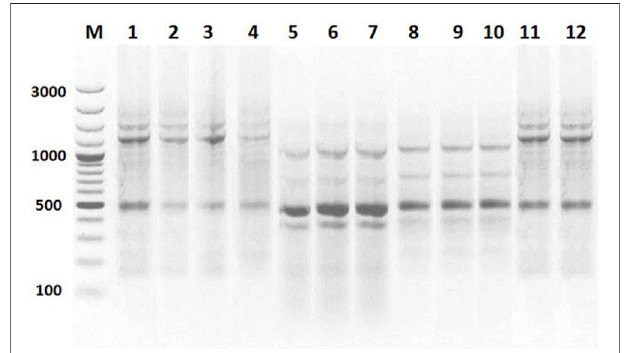
FIGURE 1 | Comparison of RAPD pro fi le for genotoxicity in Pheretima posthuma withprimerA-05.LaneM=DNAmarker(size100bp).L 1 =Control; L 2 =Wheatstraw(5%);L 3 =Wheatstraw(10%);L 4 =Wheatstraw(25%),L 5 =